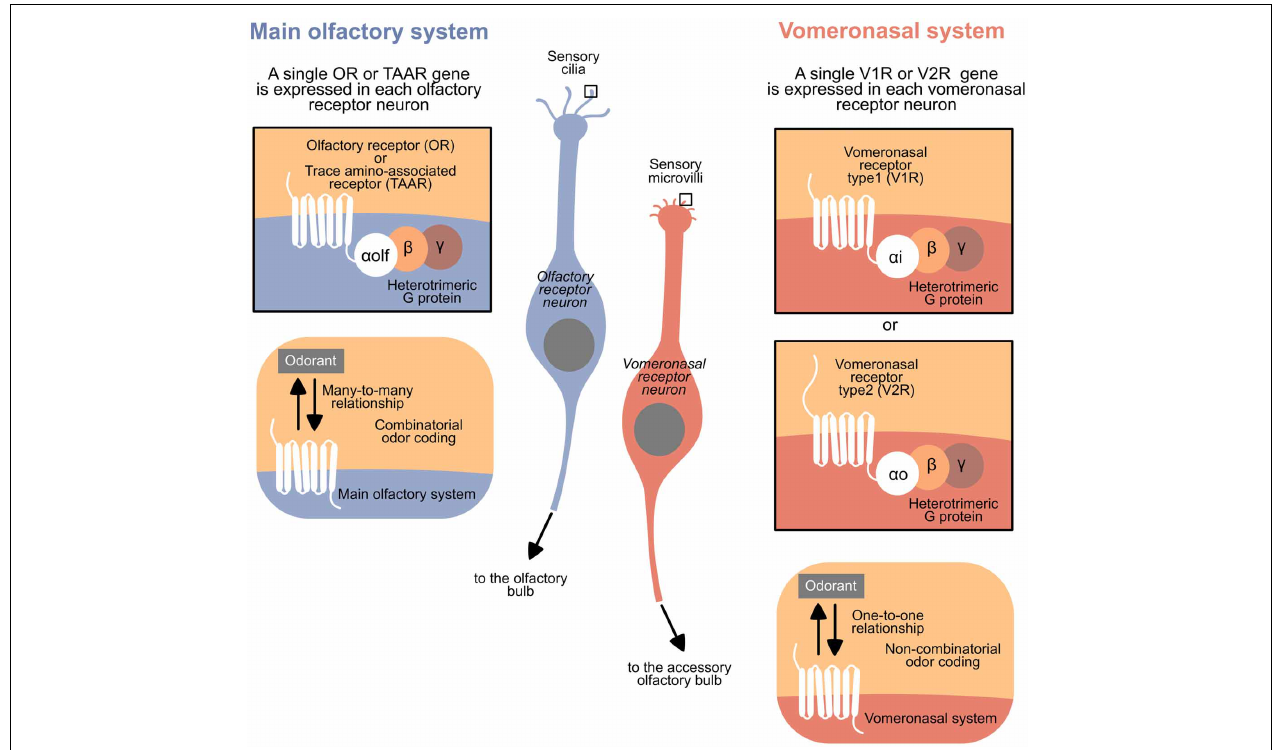
FIGURE 1 | Summary of the general differences between the main olfactory system and the vomeronasal system in vertebrates.